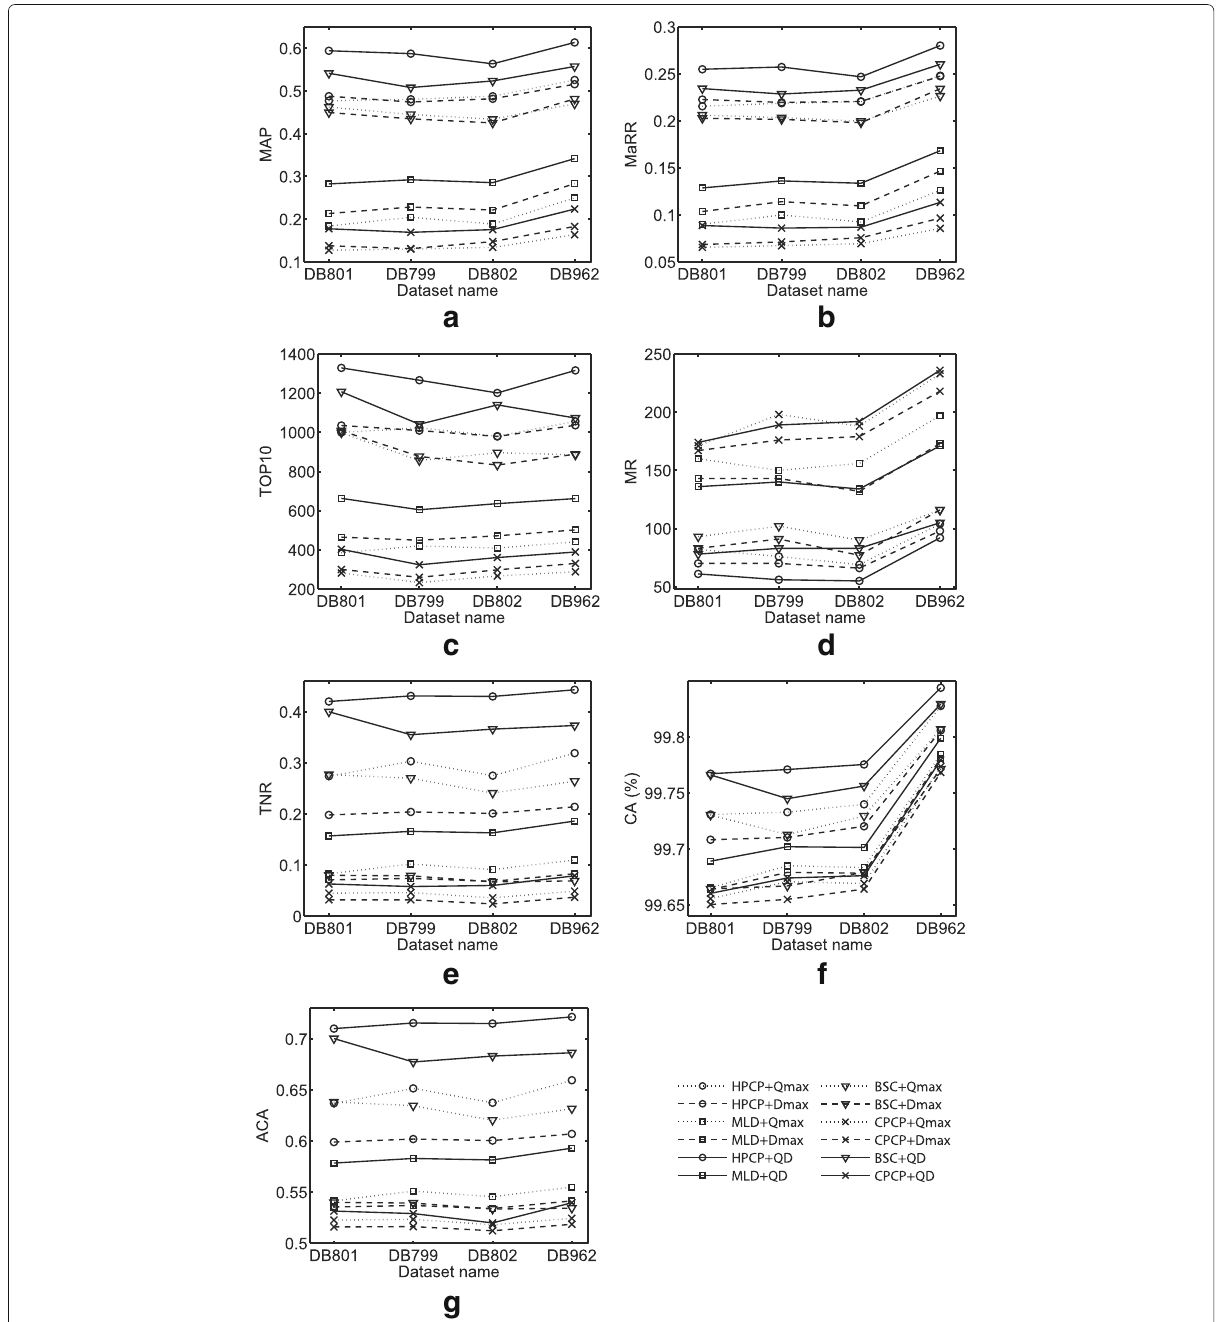
Fig. 5 Comparison of the identification accuracy in terms of a MAP, b MaRR, c TOP10, and d MR and the classification efficiency in terms of e TNR, f CA, and g ACA before and after early fusion on different data sets. QD early fusion of the Qmax and Dmax-based similarities with SNF